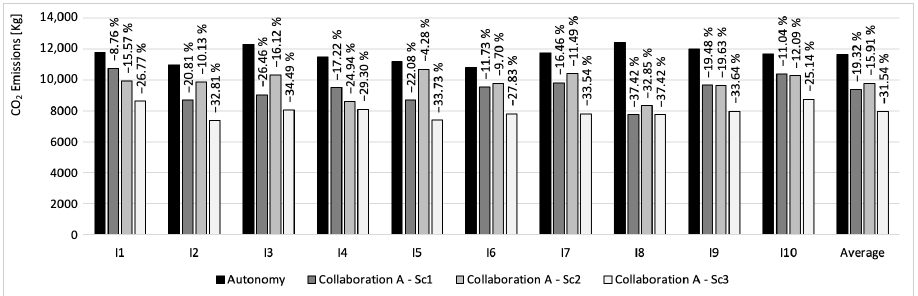
Figure 6. Comparison in terms of CO 2 emissions reduction between autonomous and collabora- tive